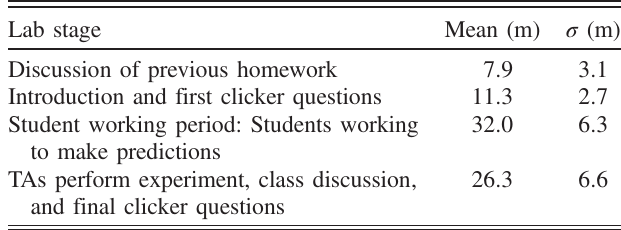
TABLE I. The time spent in each stage of the lab for all 16 observed sections. The student working period, during which students were working in pairs to complete the activity, was the longest stage of the lab.